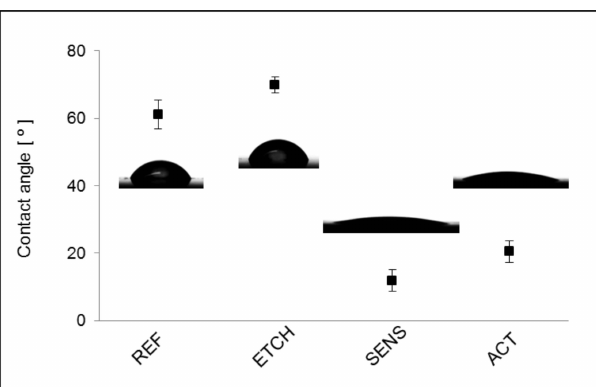
Figure 3. Water droplet contact angle measurements after pretreatment stages. REF: untreated surface; ETCH: after chemical etching; SENS: after sensitization; and ACT: after